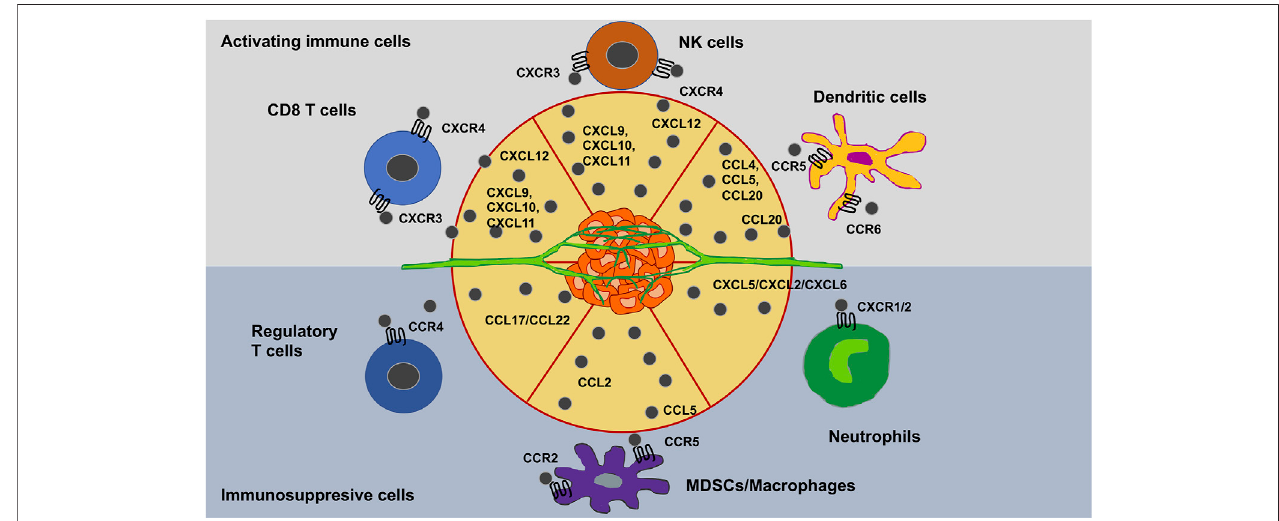
FIGURE 7 | Chemokines trigger the in fi ltration of immune cells in solid cancers microenvironments.